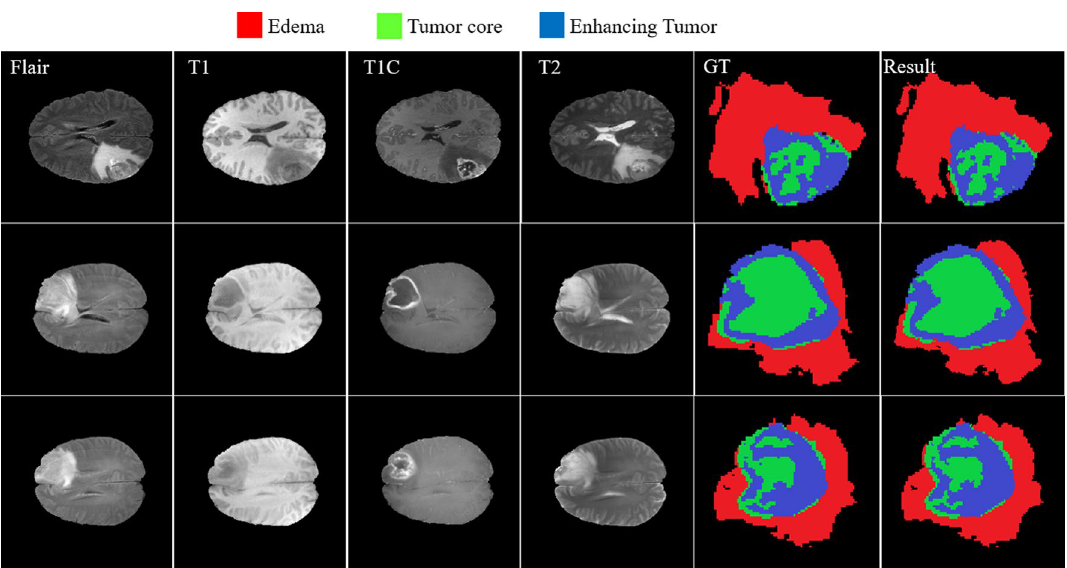
Figure 13. The results of brain tumor segmentation using the proposed strategy (the blue, green, and red colors are enhanced, core, and edema regions